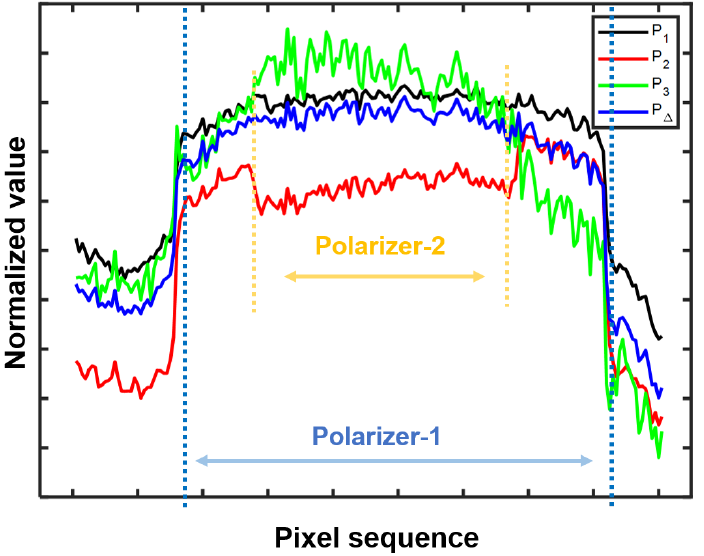
Figure 9. Intensity profiles across the four dashed lines in Figure 8c, where the IPPs metrics show clear intensity differences at the two polarizers’